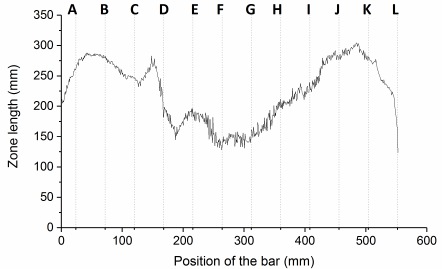
Figure 13. Graph of zone length variation across the crucible, the positions on the graph referring to the time lapse images from Figure